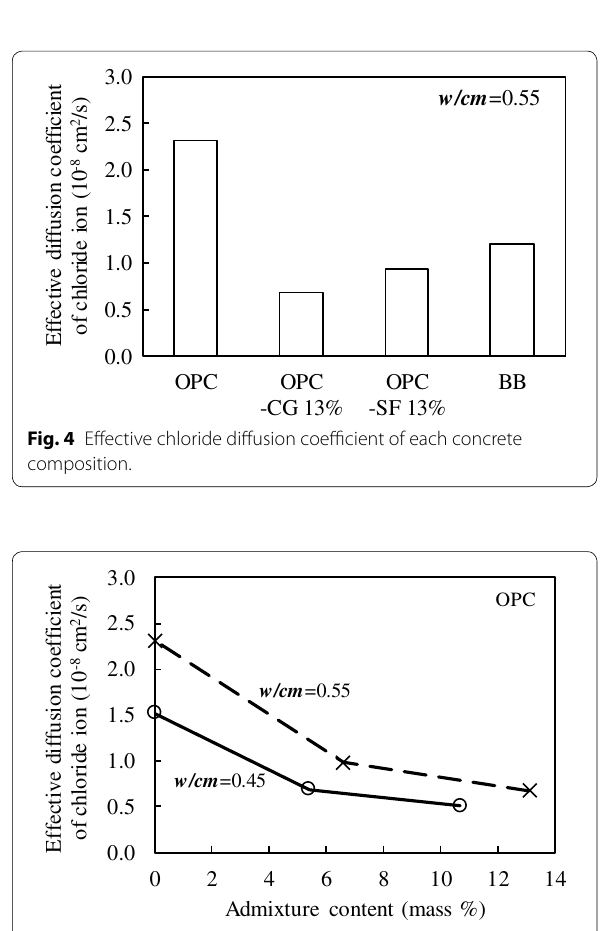
Fig. 5 Relation between admixture content and effective chloride diffusion coefficient.